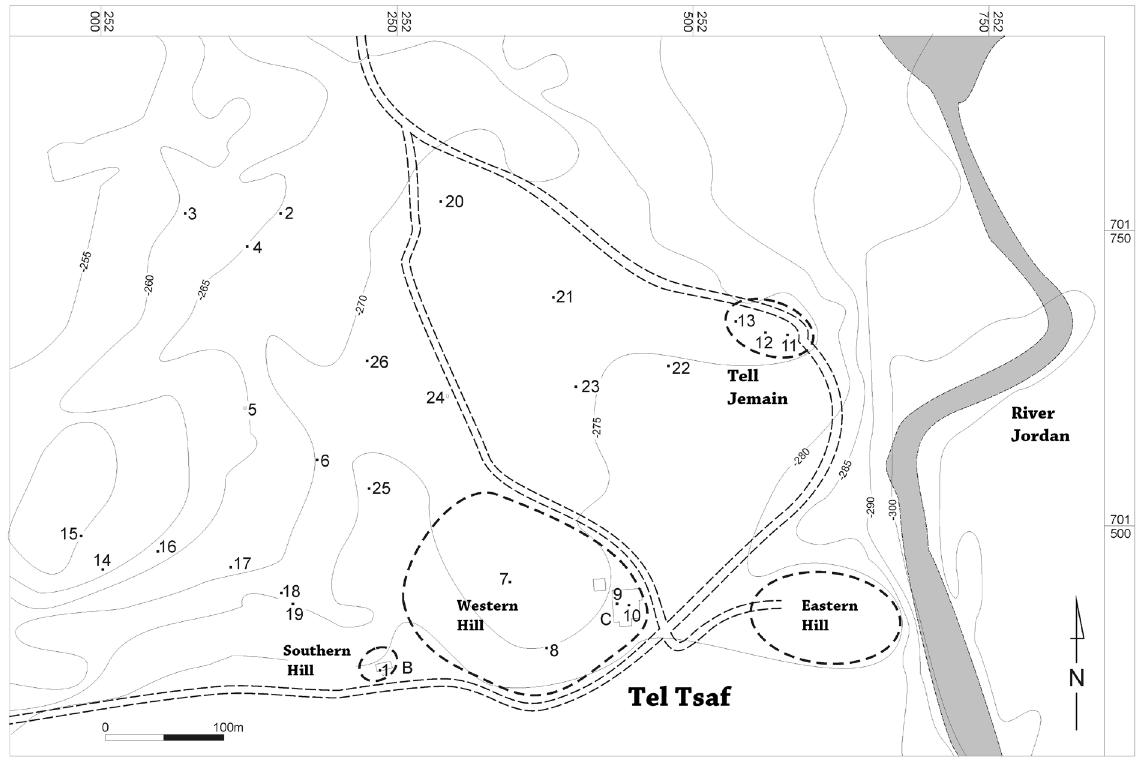
Figure 2. Hills composing the site and the excavated